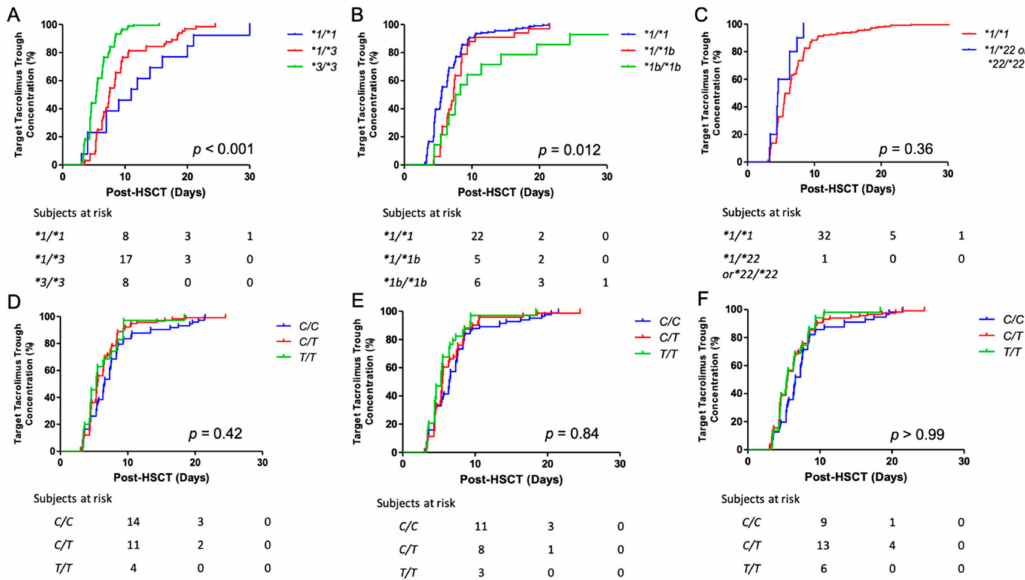
Figure 4. Time to target steady-state tacrolimus trough concentrations for CYP3A4 / 5 and ABCB1 SNPs. Time to target tacrolimus trough concentration, stratified by genotypes, are presented using Kaplan Meier curves, where the y-axis denotes the percentage of patients who reached a steady-state trough between 5 and 10 ng / mL while the x-axis denotes days post-transplant. Subjects at risk for not achieving tacrolimus target trough concentrations are shown on days + 10, + 20, and + 30 post-transplant. SNPs shown below are CYP3A5*3 ( A ), CYP3A4*1b ( B ), CYP3A4*22 ( C ), ABCB1 C1236T ( D ), ABCB1 C2677T ( E ), and ABCB1 C3435T ( F ). p < 0.05 was considered significant, and p values were adjusted for multiple comparisons using a Bonferroni correction. Abbreviations: ABCB1, ATP-binding cassette B1; CYP3A4 / 5, cytochrome P450 isoforms 4 and 5; SNP, single nucleotide